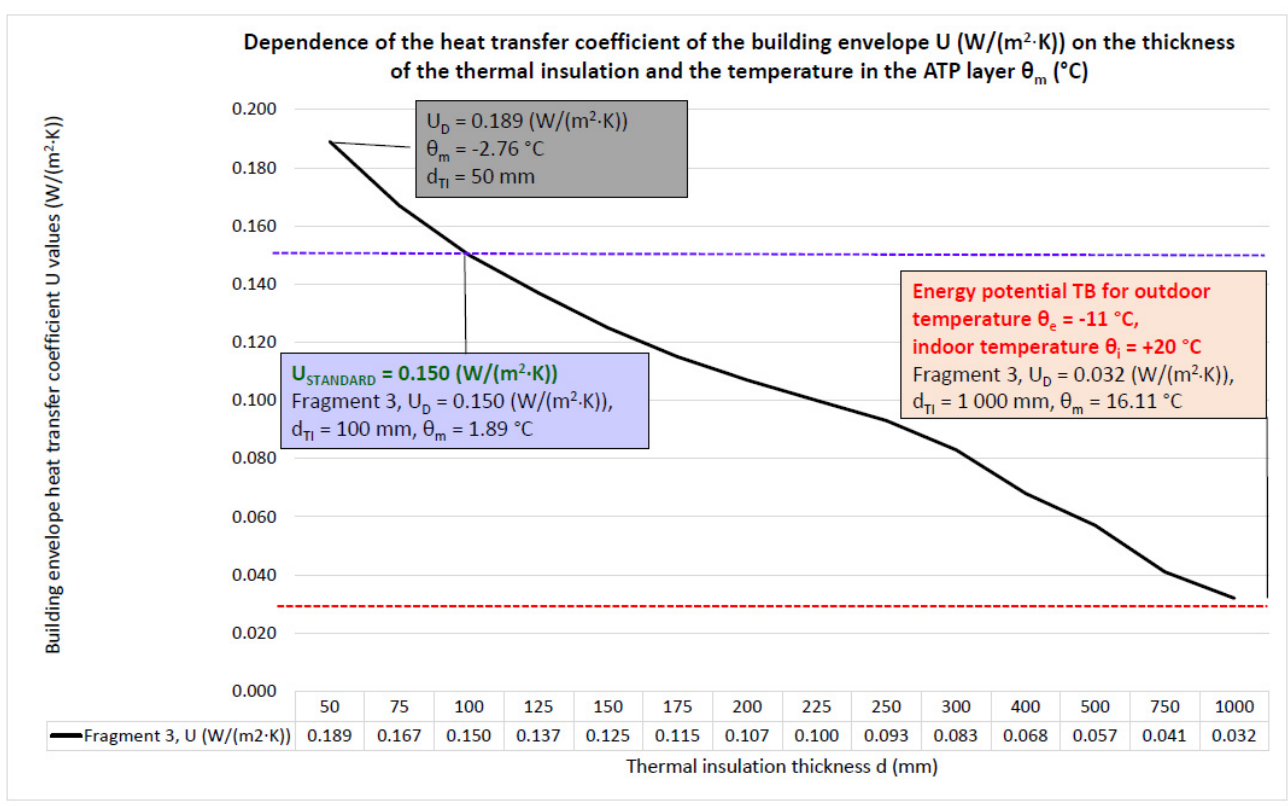
Figure 24. Graphical dependence of the dynamic thermal resistance on the thickness of the static/dy- namic thermal insulation and the mean temperature of the heat transfer medium in the ATP pipes— Fragment 3.